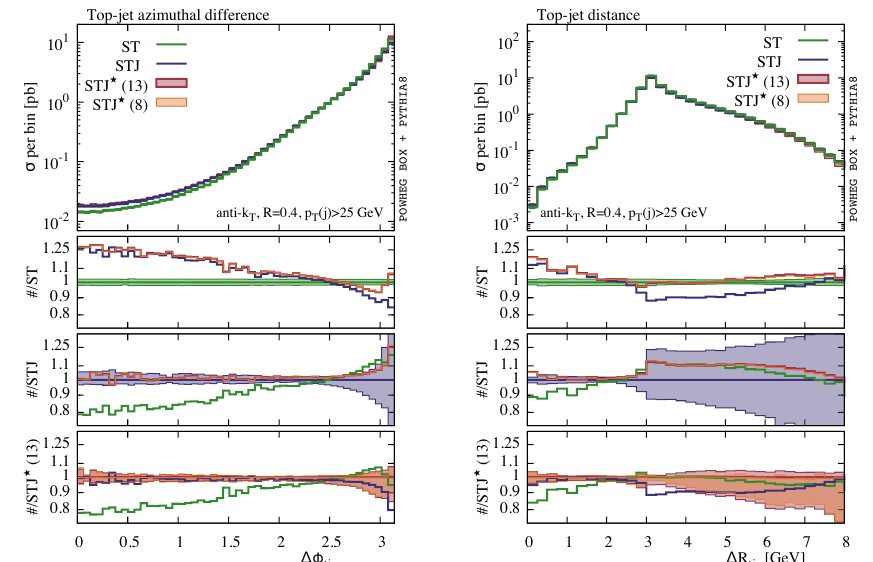
Figure 10 . The left-hand plot shows predictions for the azimuthal angle between the top quark and the leading jet in t -channel single-top production at the 8 TeV LHC. The right-hand plot similarly shows predictions for the distance between the same two objects in the (cid:17) (cid:0) (cid:30) plane. The colour coding and naming of the various predictions is as in (cid:12)gures 7{9.